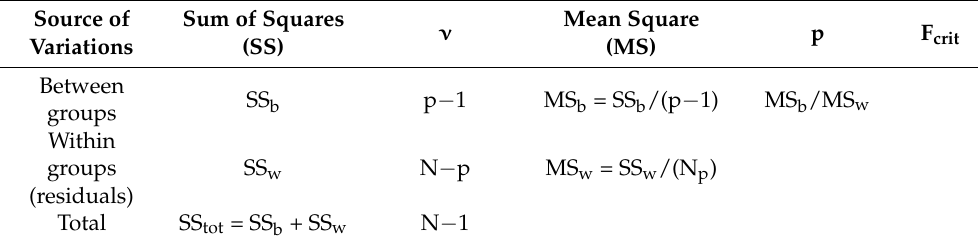
Table 1. One-way ANOVA output table, as example.